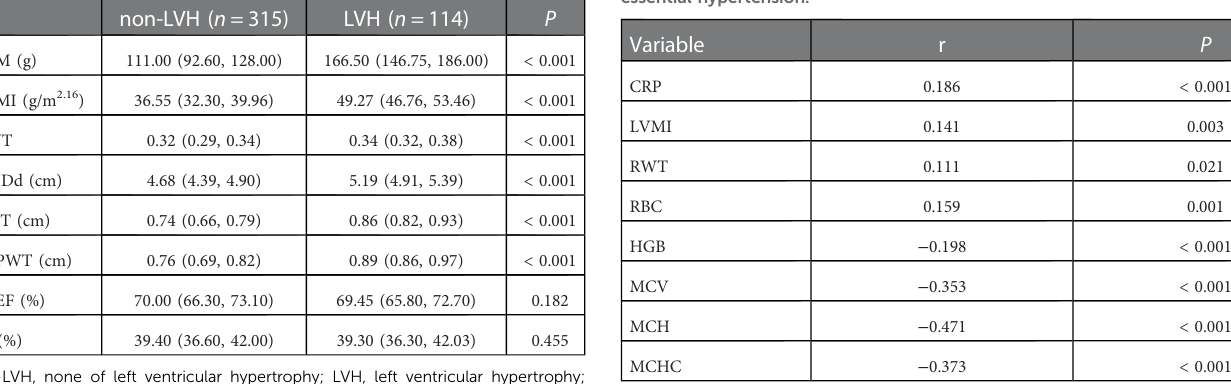
TABLE 4 The correlations between RDW and clinical indices in pediatric essential